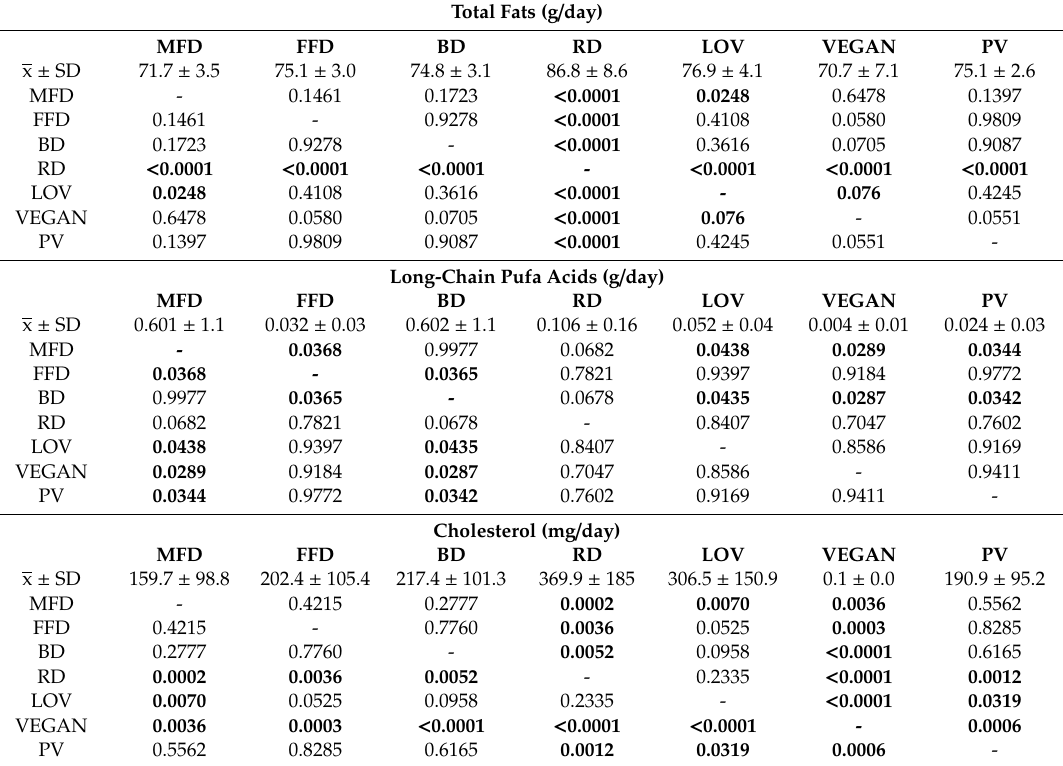
Figure 2. The content of saturated fatty acids (SFA), monounsaturated fatty acids (MUFA), and polyunsaturated fatty acids (PUFA) in diets (g/day). Table 5. The comparison of the average content of total fats, PUFA, and cholesterol between the diets (g / day; mg /